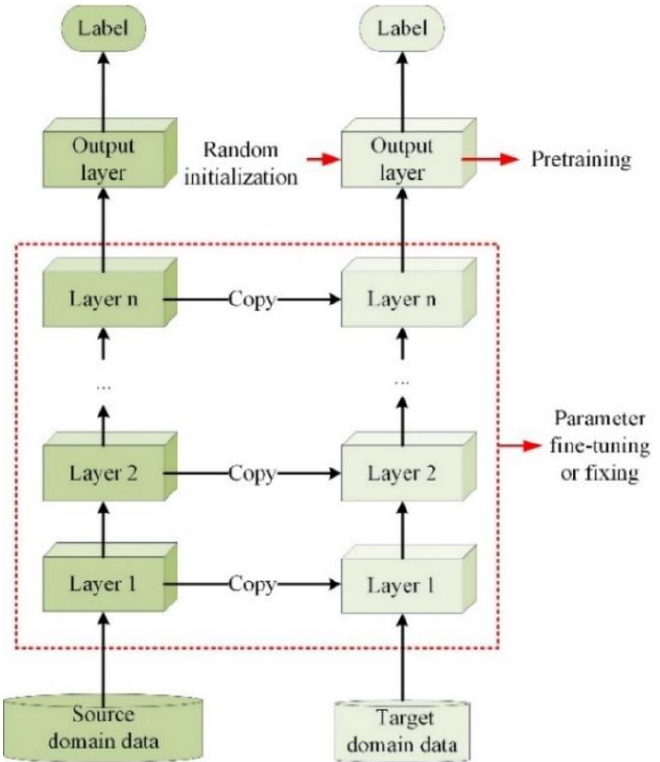
Figure 3. Schematic diagram of deep transfer learning.